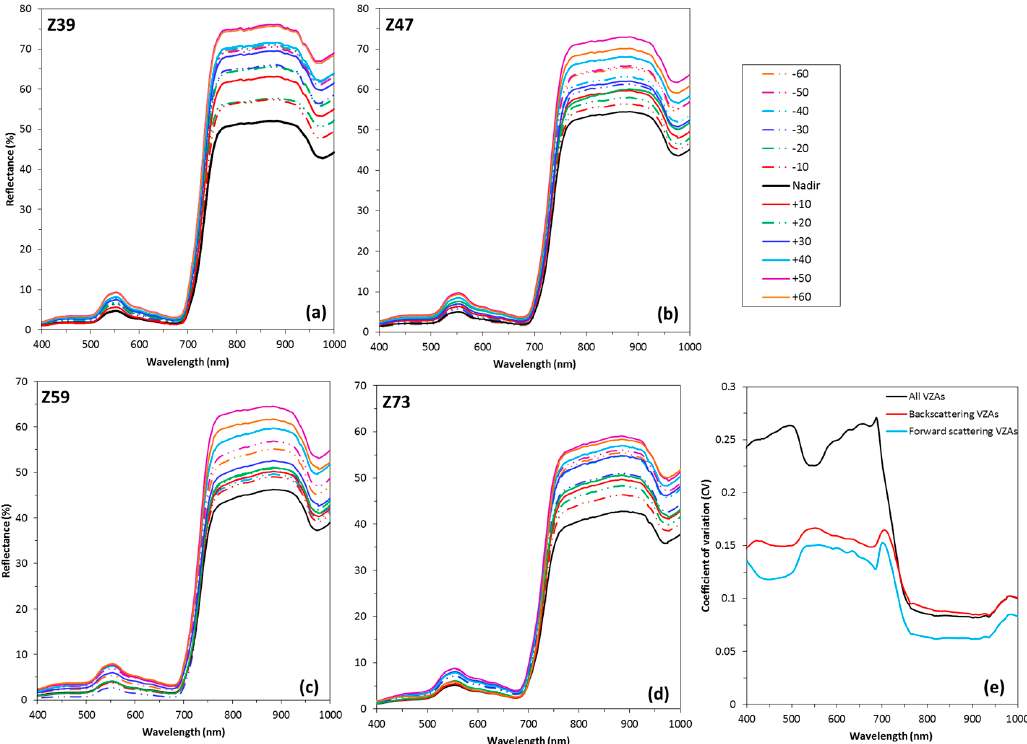
Figure 3. ( a – d ) Multi-angle spectral reflectance measured from − 60° to +60° VZAs during stem elongation (Z39), booting (Z47), heading (Z59) and milk-filling (Z73) stages of wheat in 2007; and ( e ) curves of the coefficient of variation (CV) of reflectance measured at the booting stage (Z47) among the backscattering VZAs (from +10° to +60°), forward scattering VZAs (from − 10° to − 60°) and all thirteen VZAs.